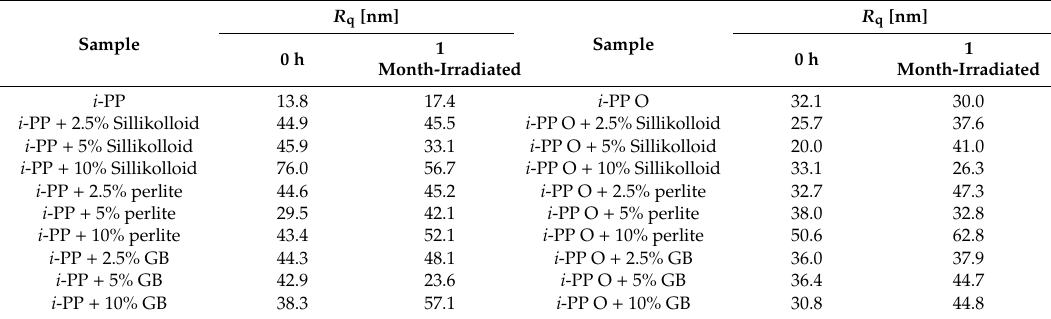
Figure 7. AFM images of the unoriented ( top ) and oriented ( bottom ) i -PP films with 5% of perlite and Sillikolloid. Scan area: 5 µ m × 5 µ m, z-scale for the unoriented films: 200 nm, for the oriented films: 300 nm. Table 5. The values of the roughness parameter ( R q , nm) for unoriented and oriented (O) isotactic polypropylene ( i -PP) films with di ff erent content of Sillikolloid, perlite, glass beads (GB), before and after 1 month of UV irradiation. A scan area: 5 μm × 5 μm.